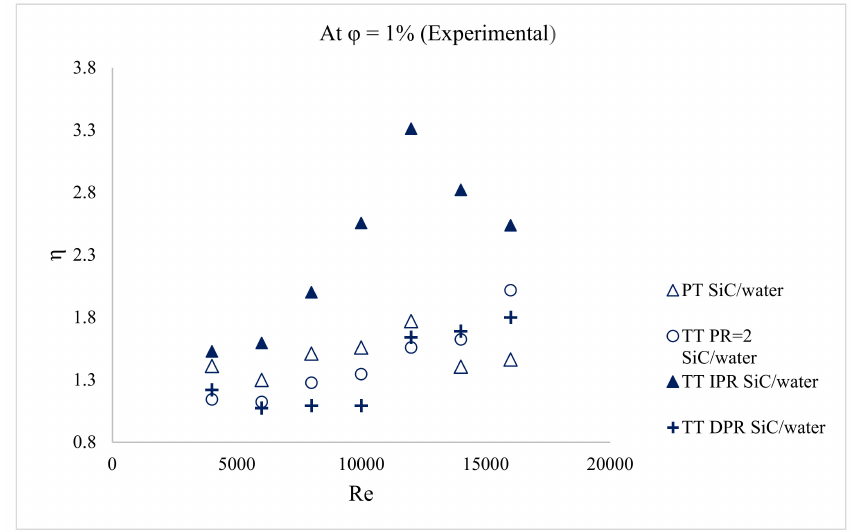
Figure 21. E ff ect of type of inserts on the overall enhancement ratio, η (Experimental)